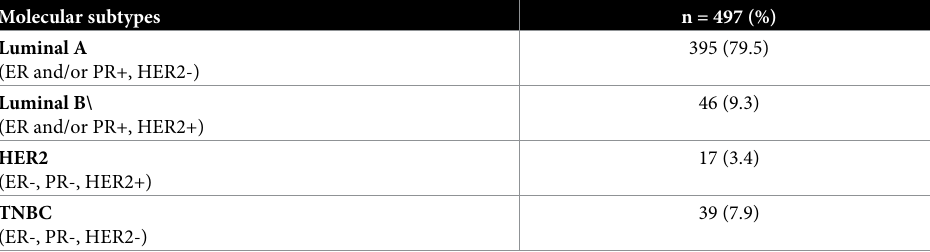
distribution of HER2 status and molecular subtypes were representative of what is observed in the BC patient population at large (HER2 status: 6.6% equivocal, 26.7% positive and 66.7% negative; molecular subtypes: 6.7% HER2, 20.0% Luminal B, 10.0% TNBC and 63.3% Luminal A) [36]. This indicates that pHER2 Y877 is well distributed among BC molecular subtypes and HER2 status, and is not specific to a subgroup in particular.